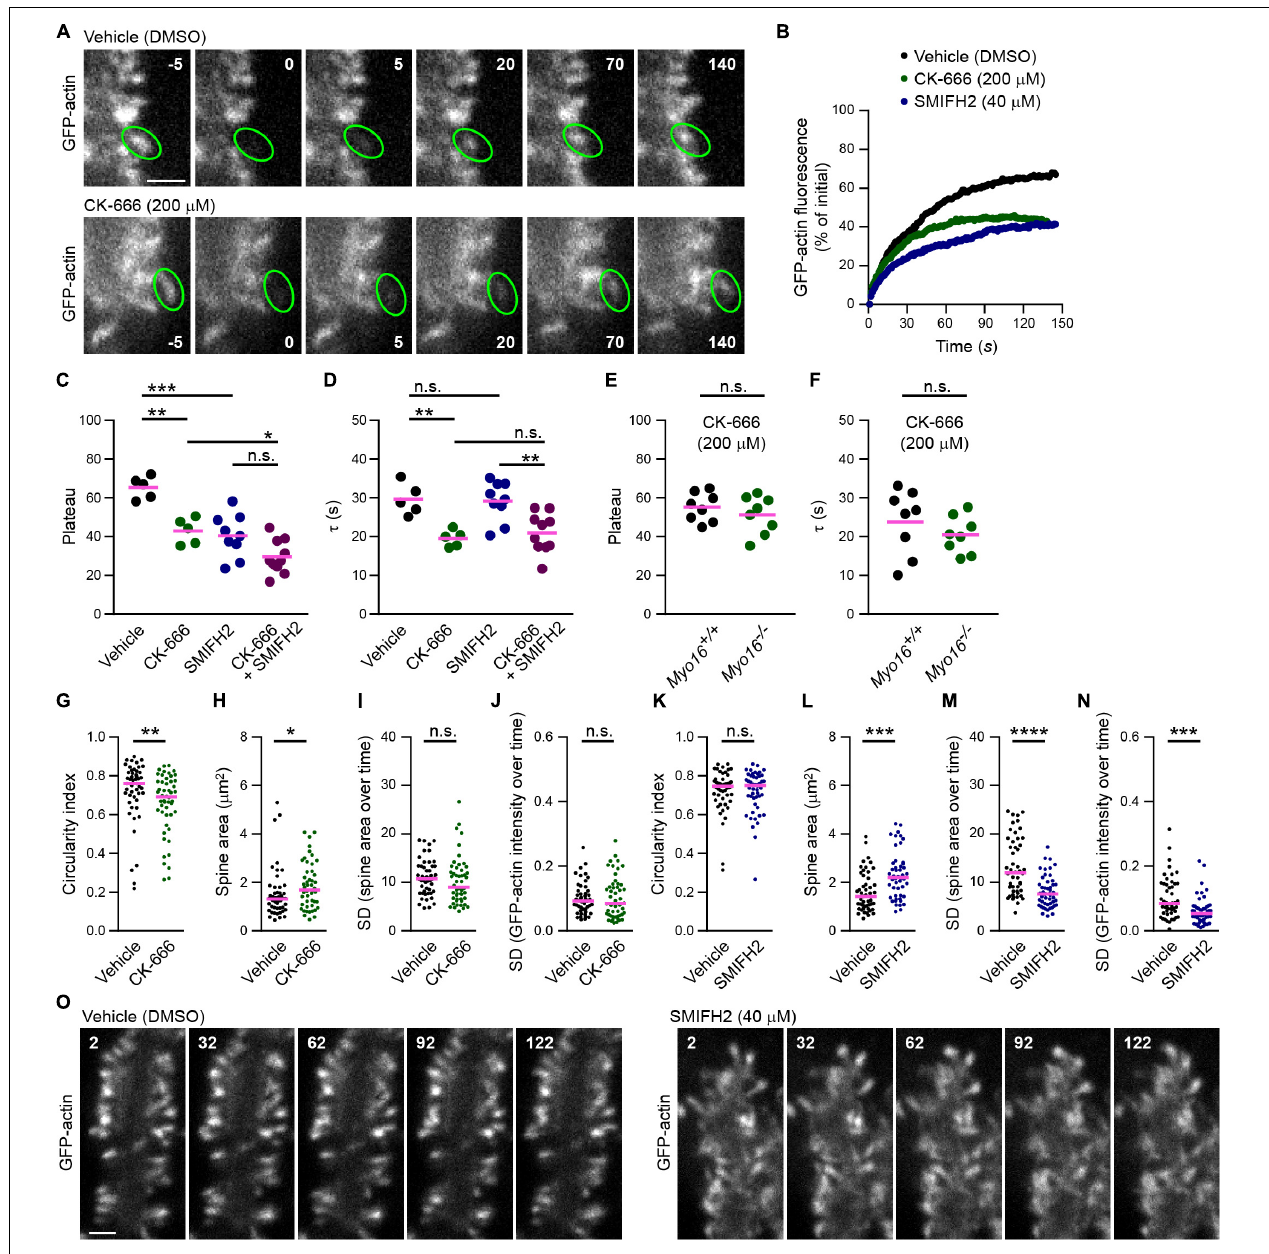
FIGURE 7 | Arp2/3 inhibition, but not formin inhibition, accelerates F-actin turnover in PC spines. (A) Examples of GFP-actin FRAP in PC spines in the absence or presence of Arp2/3 inhibitor CK-666. Wild-type PCs were co-transfected with L7/Pcp-2 promoter plasmids encoding GFP-actin and volume marker FusionRed. Shown are images depicting GFP-actin and recorded using spinning disk confocal microscopy. Upper row, vehicle-treated control (0.4% [v/v] DMSO). Lower row, treated with CK-666 (final concentration, 200 µ M). Time before and after bleaching is indicated (seconds). Green ovals highlight bleached spines. Scale bar, 2 µ m. (B) FRAP analysis of GFP-actin in spines of PCs co-transfected as in (A) and treated with CK-666 (200 µ M; green), formin inhibitor SMIFH2 (40 µ M; blue), or vehicle (black). Graph depicts recovery of GFP-actin fluorescence intensity in spines, data points represent the mean of a representative experiment. (C) GFP-actin FRAP recovery plateau in spines of PCs transfected as in (A) and treated with CK-666, SMIFH2, CK-666 + SMIFH2, or vehicle. Data are plateau values obtained from independent experiments ( n = 5–10; magenta line indicates mean); p values determined using one-way ANOVA ( p < 0.0001) followed by Sidak’s multiple comparisons test. (D) GFP-actin FRAP recovery time constant ( τ ) in spines of PCs transfected as in (A) and treated with CK-666, SMIFH2, CK-666 + SMIFH2, or vehicle. Data are τ values obtained from independent experiments ( n = 5–10; magenta line indicates mean); p values determined using one-way ANOVA ( p = 0.0003) followed by Sidak’s multiple comparisons test. (E) GFP-actin FRAP recovery plateau in spines of Myo16 em 2 knockout PCs ( Myo16 − / − ) and Myo16 + / + littermate PCs transfected as in (A) and treated with CK-666. Data represent plateau values obtained from independent experiments ( n = 8; magenta line indicates mean); p value determined using Student’s t -test. (F) GFP-actin FRAP recovery time constant ( τ ) in spines of Myo16 em 2 knockout PCs ( Myo16 − / − ) and Myo16 + / + littermate PCs transfected as in (A) and treated with CK-666. Data represent plateau values obtained from independent experiments ( n = 8; magenta line indicates mean); p value determined using Student’s t -test. (G) Circularity index of spines of PCs treated with CK-666 or vehicle and transfected as in (A) . Data